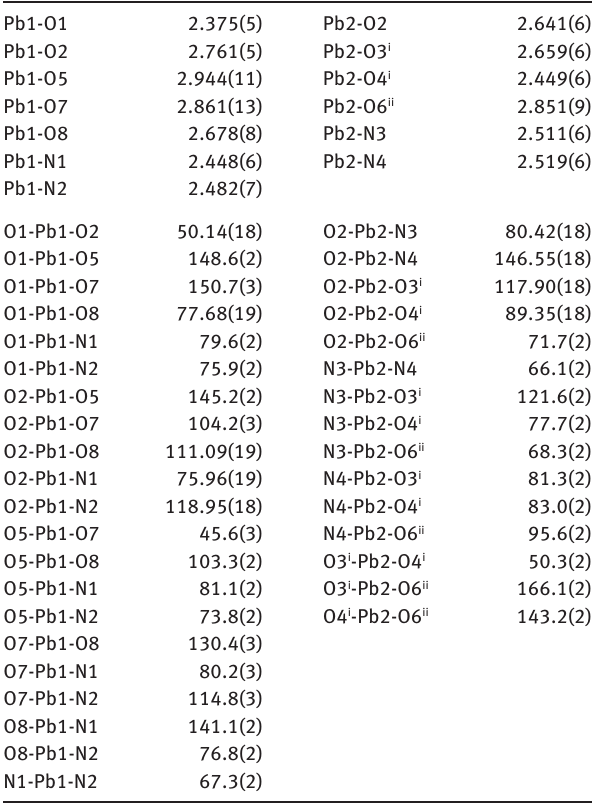
Table 1: Selected bond lengths (Å) and angles (deg) for the